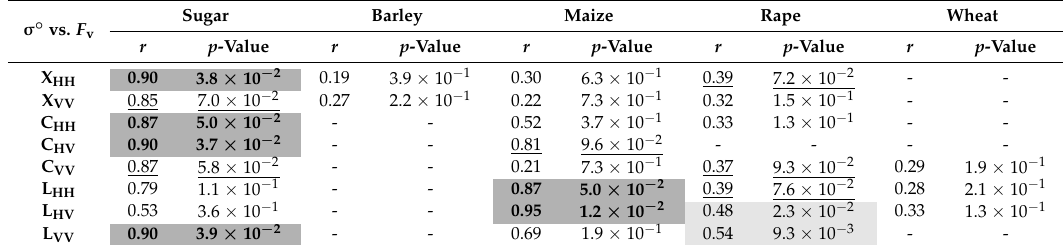
Table 5. r of σ ◦ vs. F v for plots covered by vegetation. Quasi -significant correlations are outlined; significant correlations are highlighted in light-grey; very strong and significant correlations are highlighted in dark-gray with values in bold; very weak correlations are not